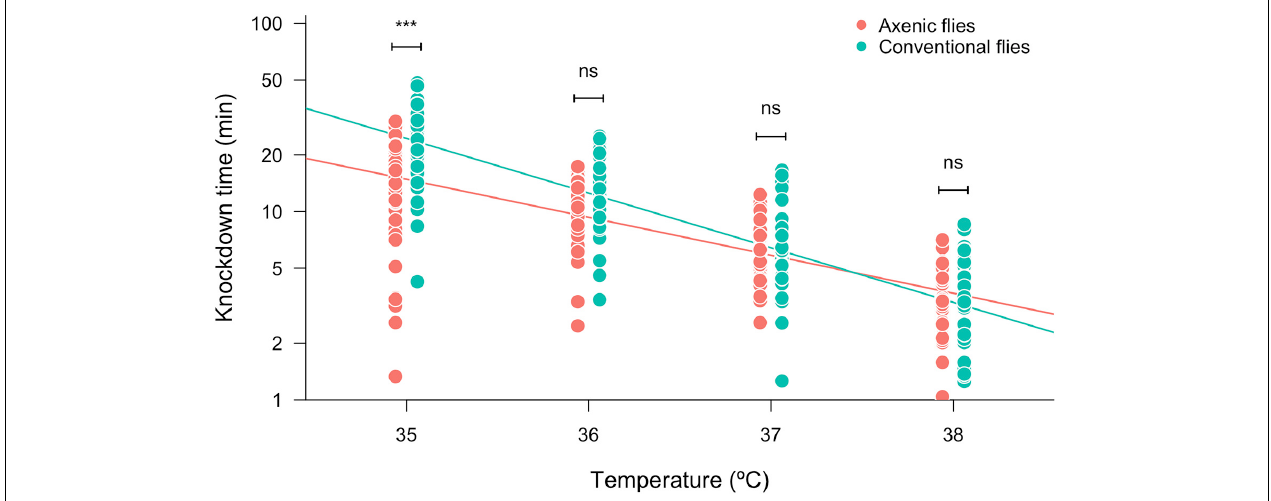
FIGURE 1 | Heat tolerance (measured as log 10 -transformed knockdown time) of axenic and conventional flies estimated at different assayed temperatures. Symbols above box plots denote non-significant (ns) or significant differences between the axenic and conventional flies obtained from a linear model (*** P < 0.001).